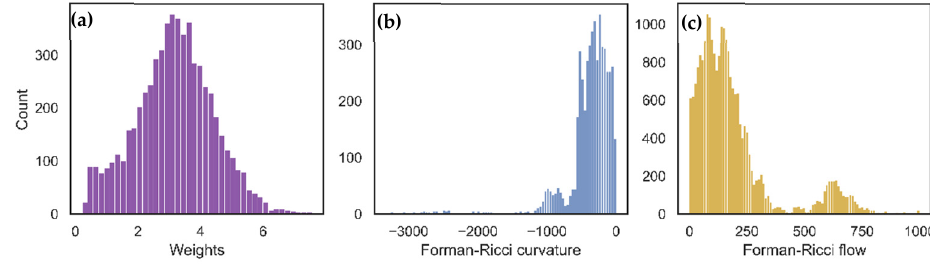
Figure 1. The distribution of ( a ) weights, ( b ) Forman–Ricci curvature, and ( c ) weights after 20 itera- tions of Forman–Ricci flow.